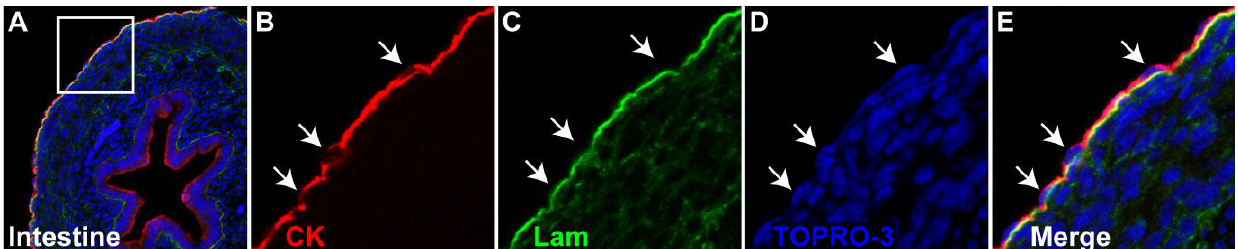
Figure 2. Mesothelial cell structure. ( a ) Transverse section through a chick embryonic day 8 small intestine. The mesothelium has attained a mature configuration by this developmental stage. (b (cid:177) e) Magnified view of boxed area shown in A. ( b ) Mesothelial cells (arrows) are cytokeratin (CK, red) positive. ( c ) A laminin (lam, green) positive basement membrane underlies the mesothelium. ( d ) Mesothelial nuclei are flat in shape (arrows). (e) Merge of B (cid:177)